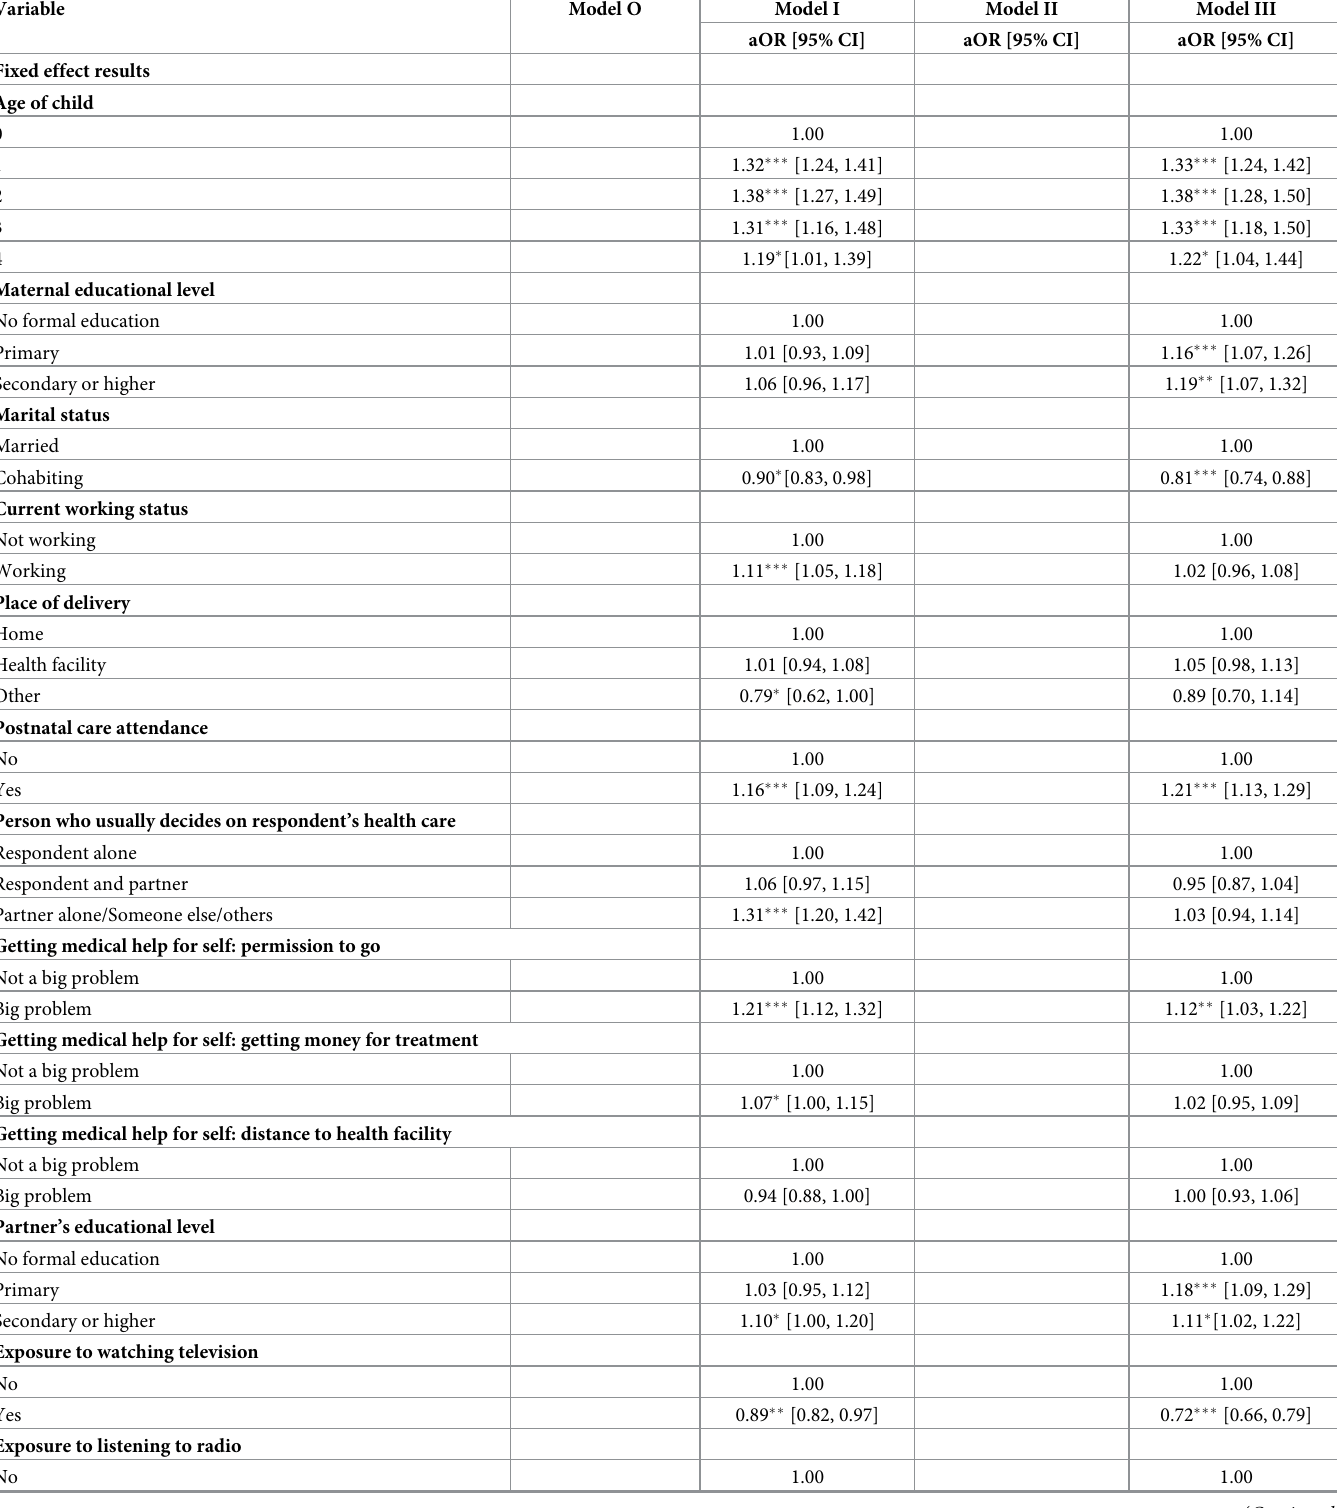
Table 3. Fixed and random effect analysis of predictors of diarrhoea treatment among children in sub-Saharan